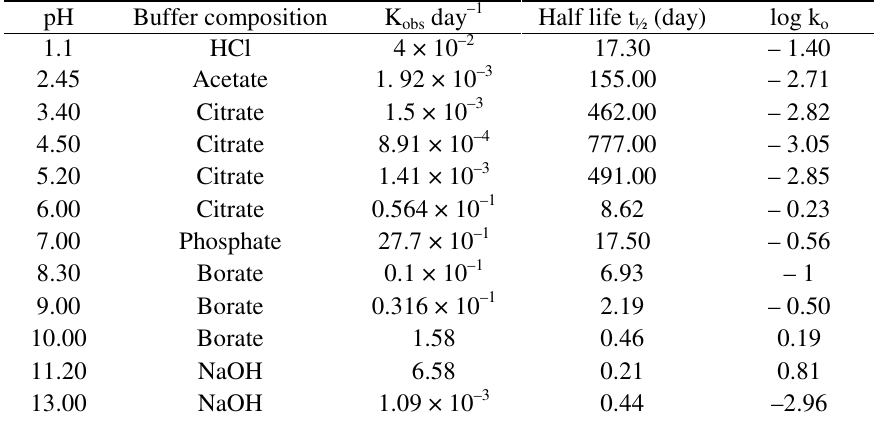
Table 4. The calculated pseudo-first order rate constant (k of nicardipine HCl at various pH values at room temperature (at 22 o C).